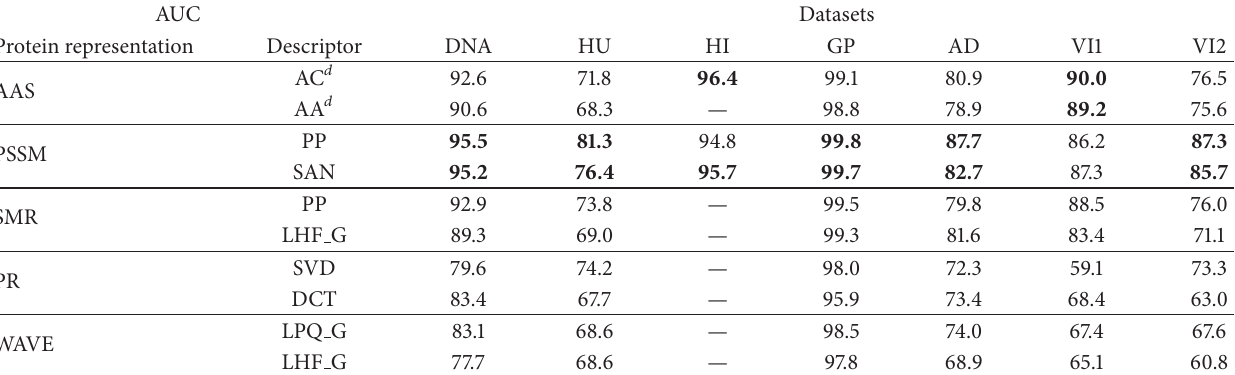
Table 4: Comparison in terms of AUC in 2 class problems.